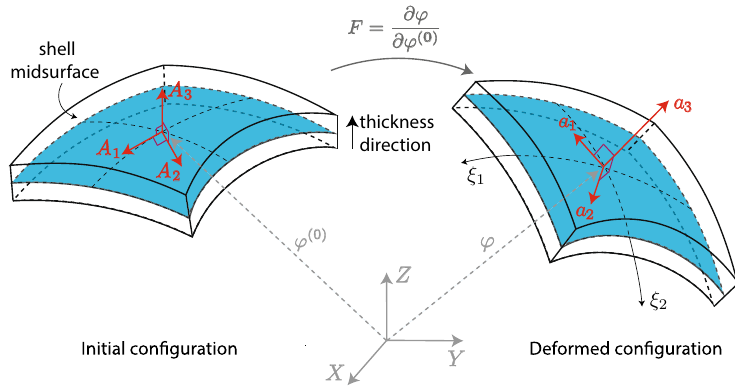
Figure 1. Schematic drawing illustrating the basis vectors in the initial and deformed